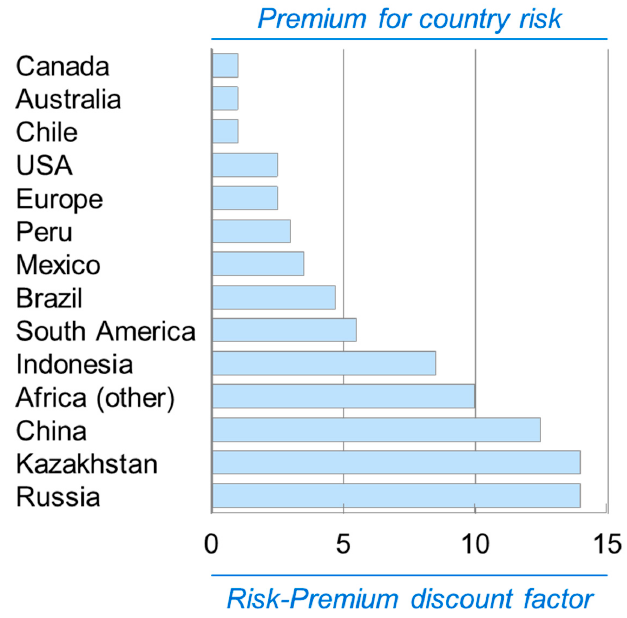
Figure 6. Premium for country risks [46].